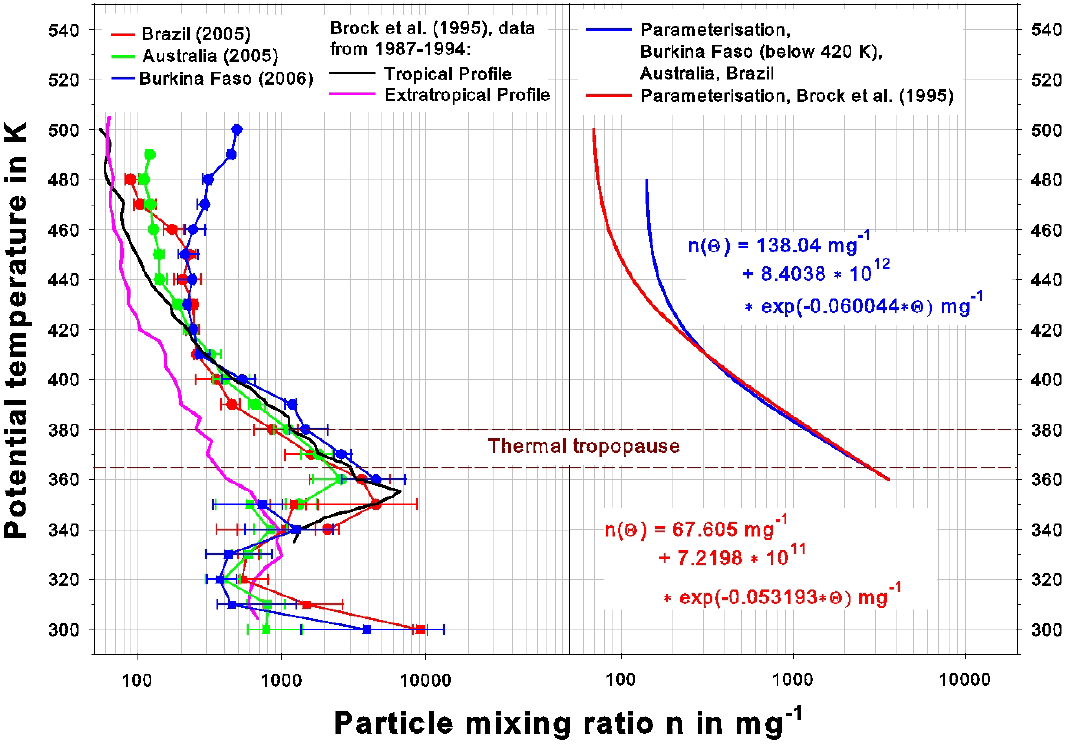
Fig. 6. Summary of all tropical profiles for submicron particle mixing ratios n from 2005 and 2006. The solid symbols in the left panel are 10K potential temperature bins with medians, 25%, and 75% percentiles. The black (purple) line shows the results from Brock et al. (1995), representing tropical (extra-tropical) measurements with the NASA ER-2 between 1987 until 1994. The symbols with circles are n 6 (red and green), and n 10 (blue) COPAS data from the M-55 “Geophysica”. The measurements below 350 K are from the DLR Falcon 20 (red – n 13 ; blue – n 10 ; green – n 5 ) . Right panel: Two parameterisations derived from the n 6 , n 10 vs. potential temperature ( 2) data in the left panel. The lowest and highest levels of the cold point tropopause for SCOUT-AMMA, TROCCINOX, and SCOUT-O3 are indicated by the